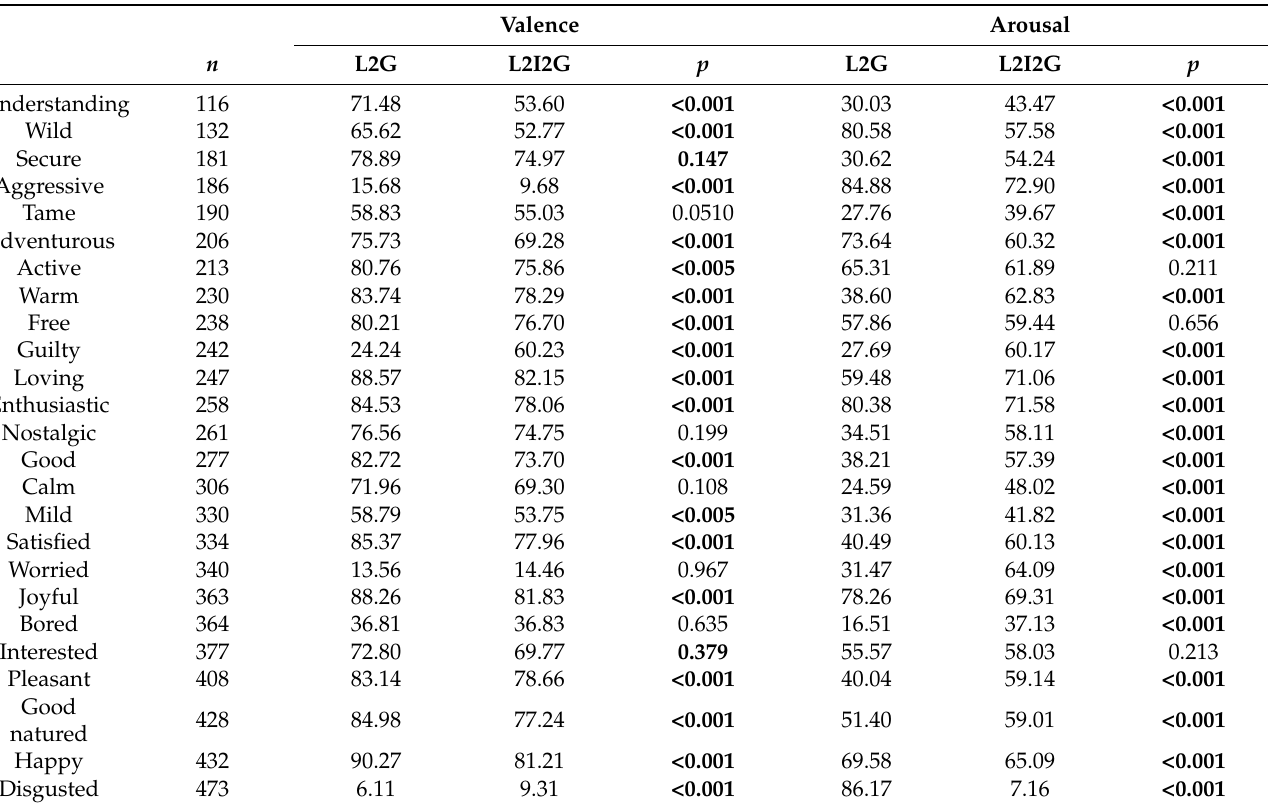
Table 2. Mean valence and arousal ratings for each emotion term, determined from the direct ( Label2Grid or L2G) and indirect ( Label2Image2Grid or L2I2G) mapping of the terms to the valence– arousal space, together with the results of the Wilcoxon signed-rank test. Bold indicates a significant difference between the indirect and direct mappings. Here, n represents the number of participants that used the emotion terms at least